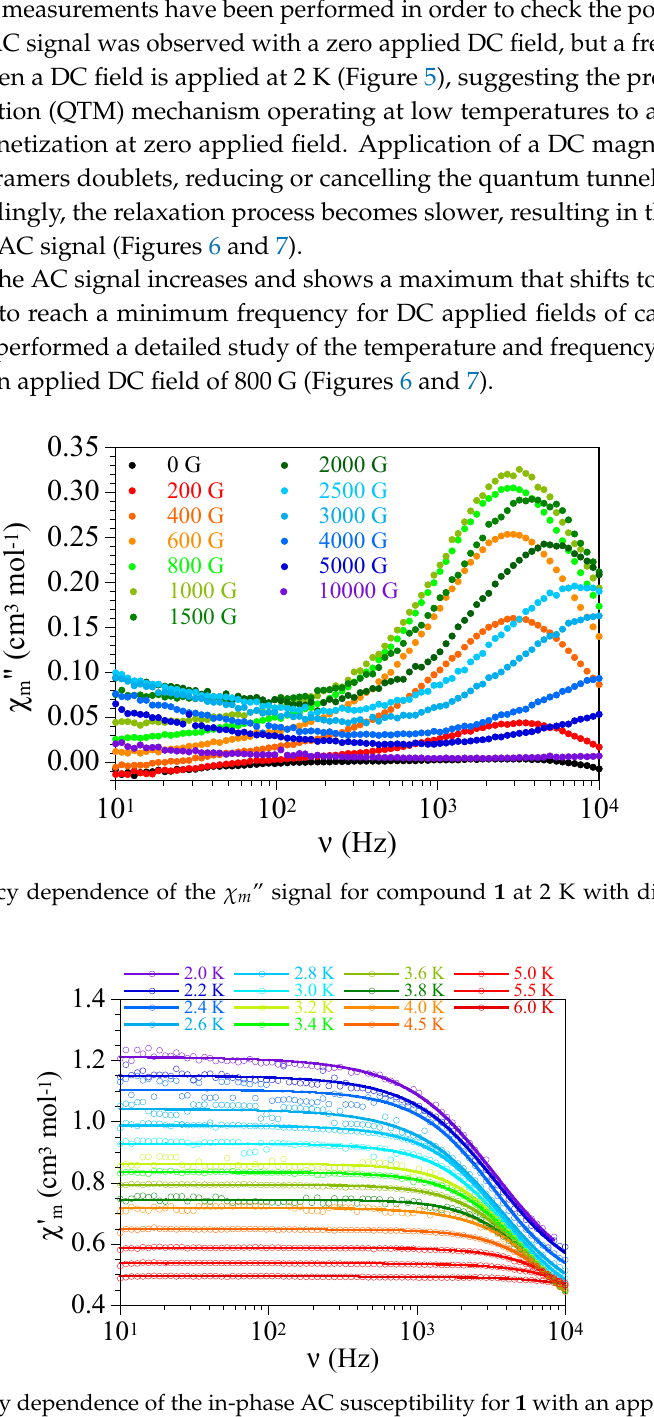
Figure 4. Isothermal reduced magnetization of compound 1 at 1.9 K (green), 3.0 K (dark blue), 5.0 K (red), and 8.0 K (cyan). Solid lines are the best-fit parameters to the model (see text).